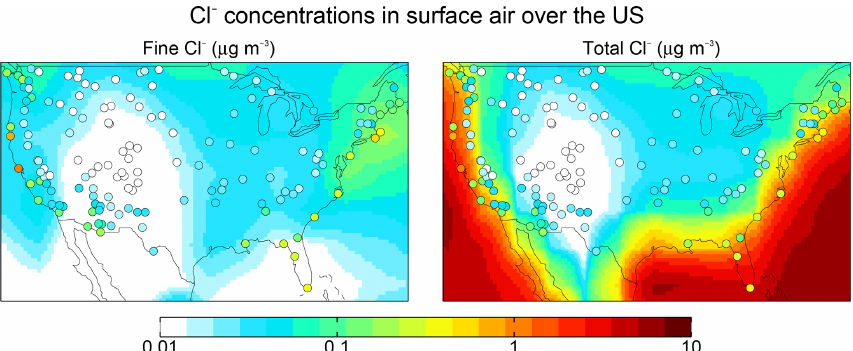
Figure 5. Aerosol Cl − concentrations in surface air over the contiguous US. Values are annual means for 2016. GEOS-Chem model values are shown as contours separately for fine Cl − ( < 1µm diameter) and total Cl − . Observations from the IMPROVE network ( < 2 . 5µm diameter) are shown as circles and are the same in both panels; one would expect them to be higher than the model fine Cl − but lower than total Cl − . Table 4. Surface air mixing ratios of reactive chlorine (Cl ∗ ) a Location Modeled Measured mean Reference Cl ∗ (ppt) Cl ∗ (ppt) Atlantic cruise near Europe 43 27 b Keene et al. (2009) Appledore Island (US east coast) 17 < 20 Keene et al. (2007) Atlantic cruise near North Africa 5 < 24 Keene et al. (2009) Southern Ocean cruise 4 < 24 Keene et al. (2009) Hawaii 4 6 Pszenny et al. (2004) < 24 Keene et al. (2009) 0.2 < 14 Impey et al.